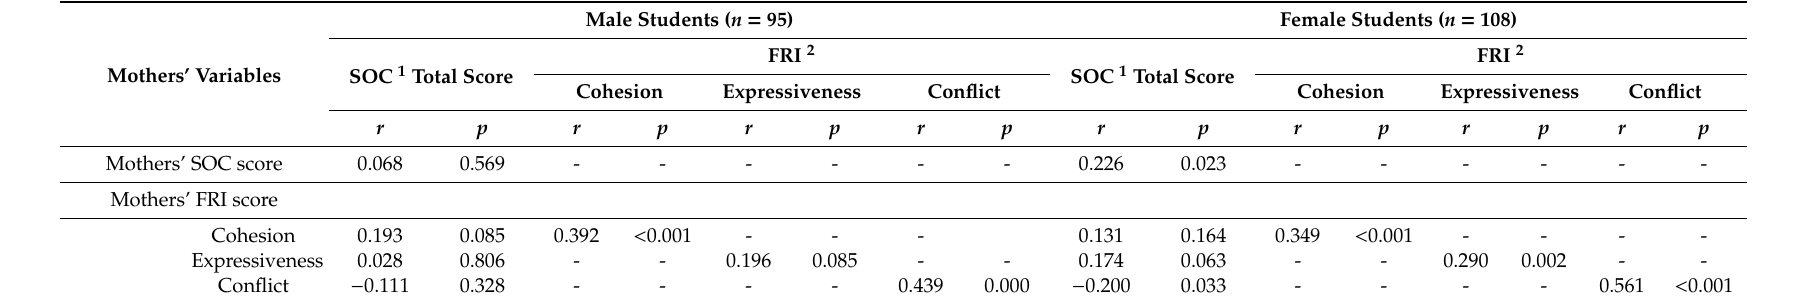
Table 3. Mother–child SOC correlation (mother–child common variables).